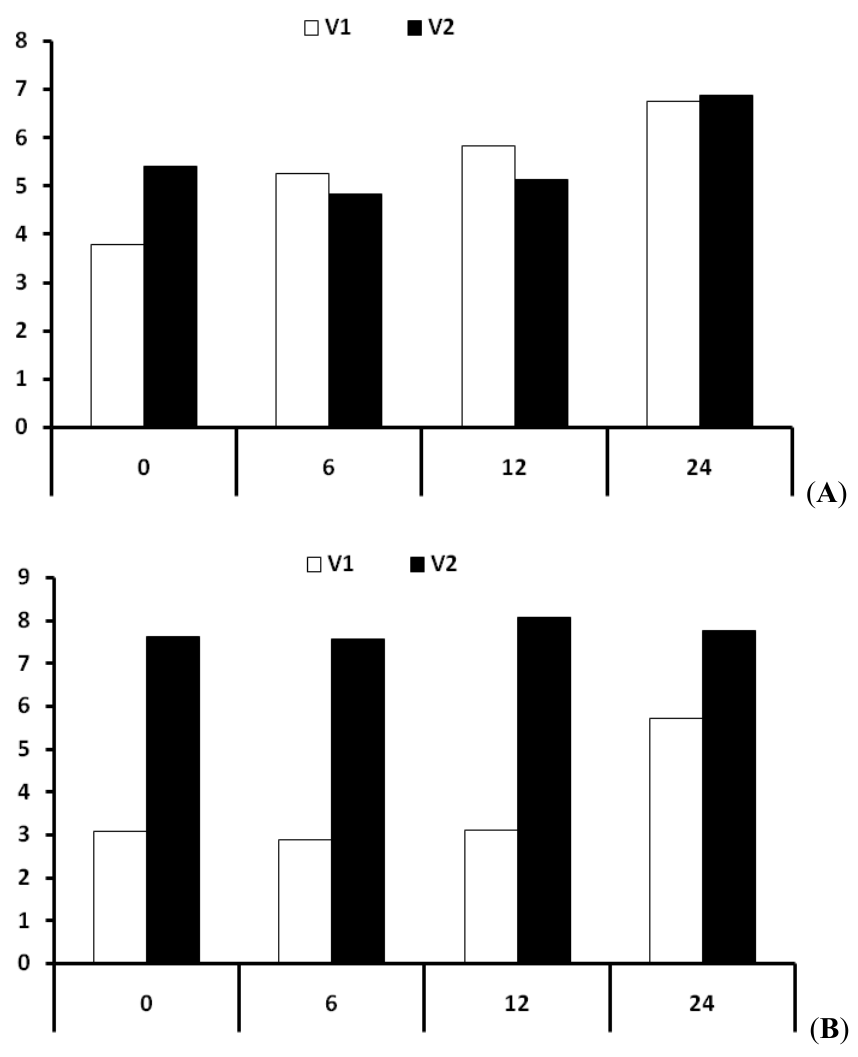
Figure 4. ( A ) Time-course studies of proline accumulation in root tissues of two contrasting canola cultivars after salt stress. The sensitive canola line (Cyclone) is represented by V1, whereas, the tolerant one is represented by V2 (Dunkled). Average of three determinations is presented with bars. ( B ) Time-course studies of proline accumulation in shoot tissues of two contrasting canola cultivars after salinity stress. The sensitive canola line (Cyclone) is represented by V1, whereas, the tolerant one is represented by V2 (Dunkled). Average of three determinations is presented with